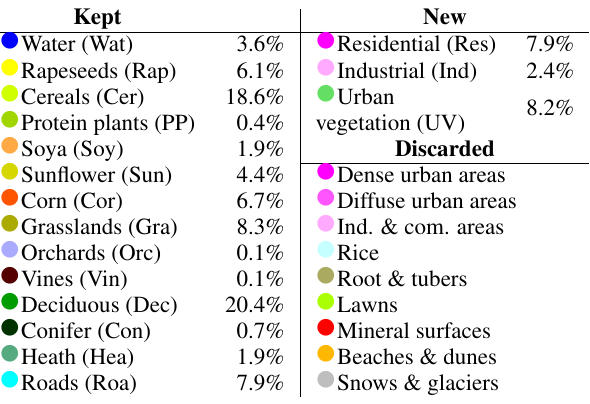
Table 4. OSO nomenclature adaptations with discraded, kept and new classes, their data distribution, acronyms and color legend